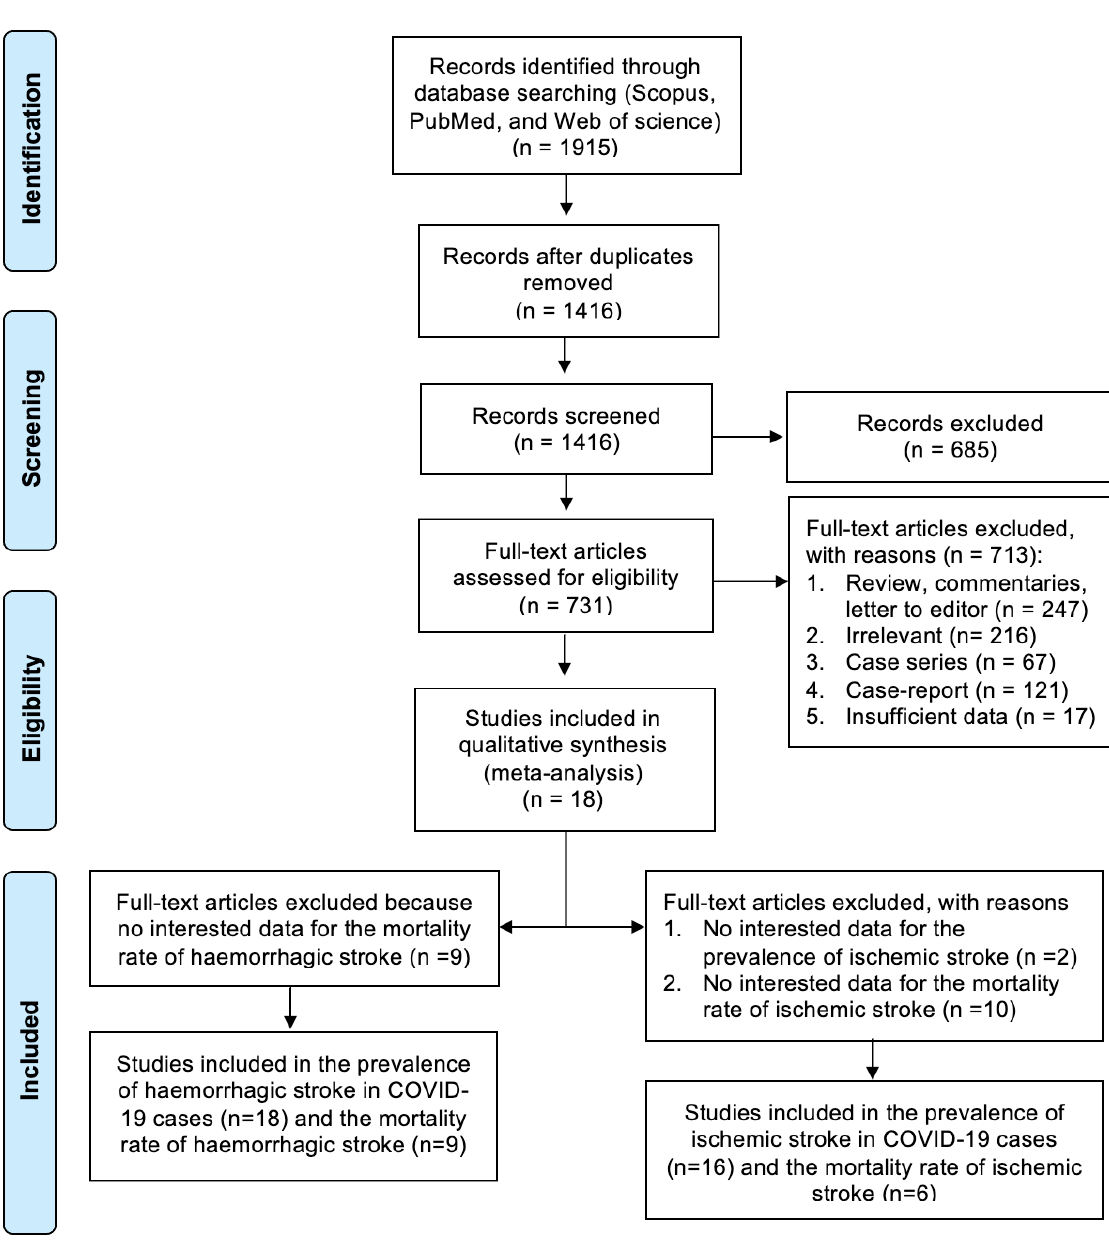
Figure 1. Flowchart of the literature search according to